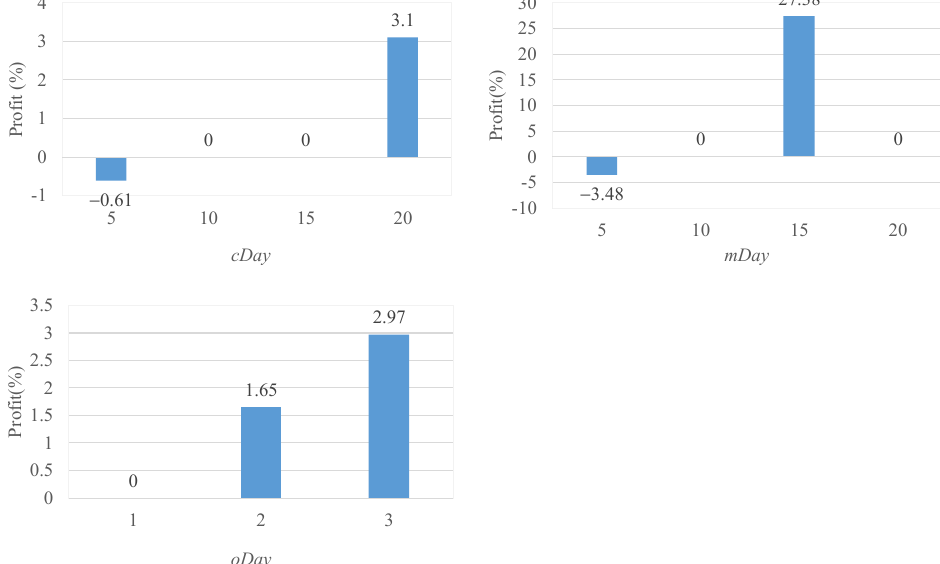
Figure 8. Profits from different parameter settings on three-year dataset (2010–2012).